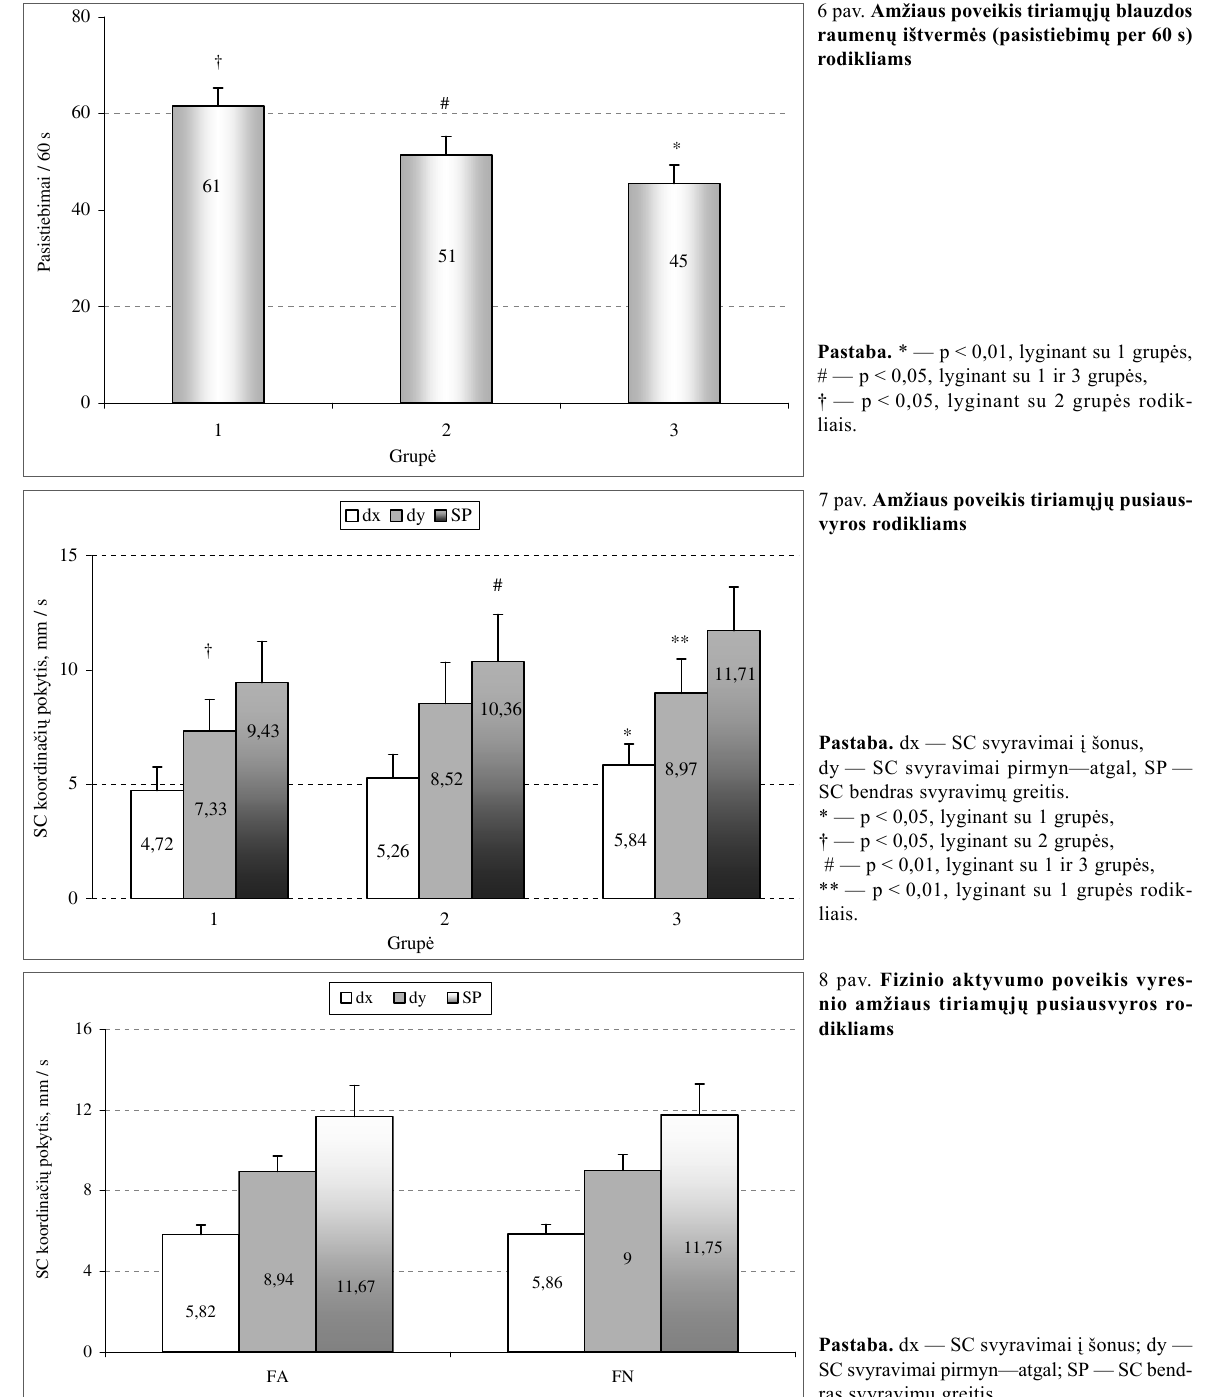
ras svyravim ų tyrimo rezultatai statistiškai reikšmingai nesiskyr ė (8 pav.).